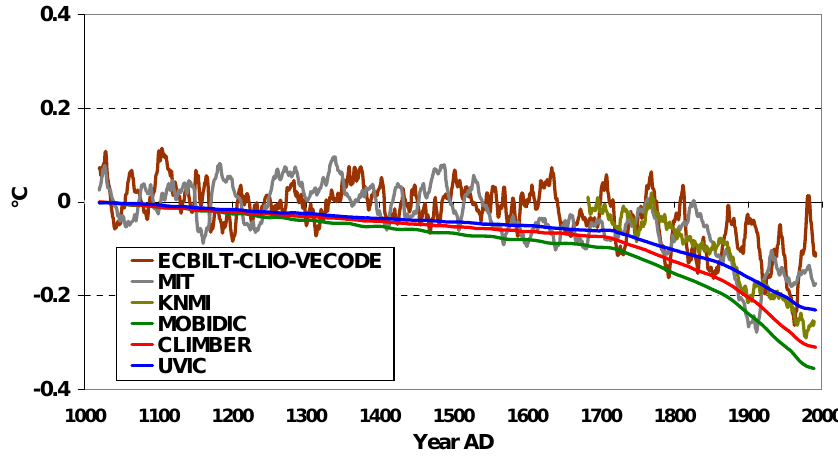
Gaillard et al. Fig. 1 Fig. 1. Decrease in mean global temperature over the Northern Hemisphere due to the biophysical feedback (increased albedo) of an estimated decrease in forest cover between AD 1000 and 2000 as simulated by six different climate models (see details on the climate models in Brovkin et al., 2006). Land-use changes were based on HYDE [History Database of the Global Environment] version 2.0 for the period AD 1700–2000, and on a constant rate of decrease in forest cover between 1000 and 1700 (from Brovkin et al., 2006;